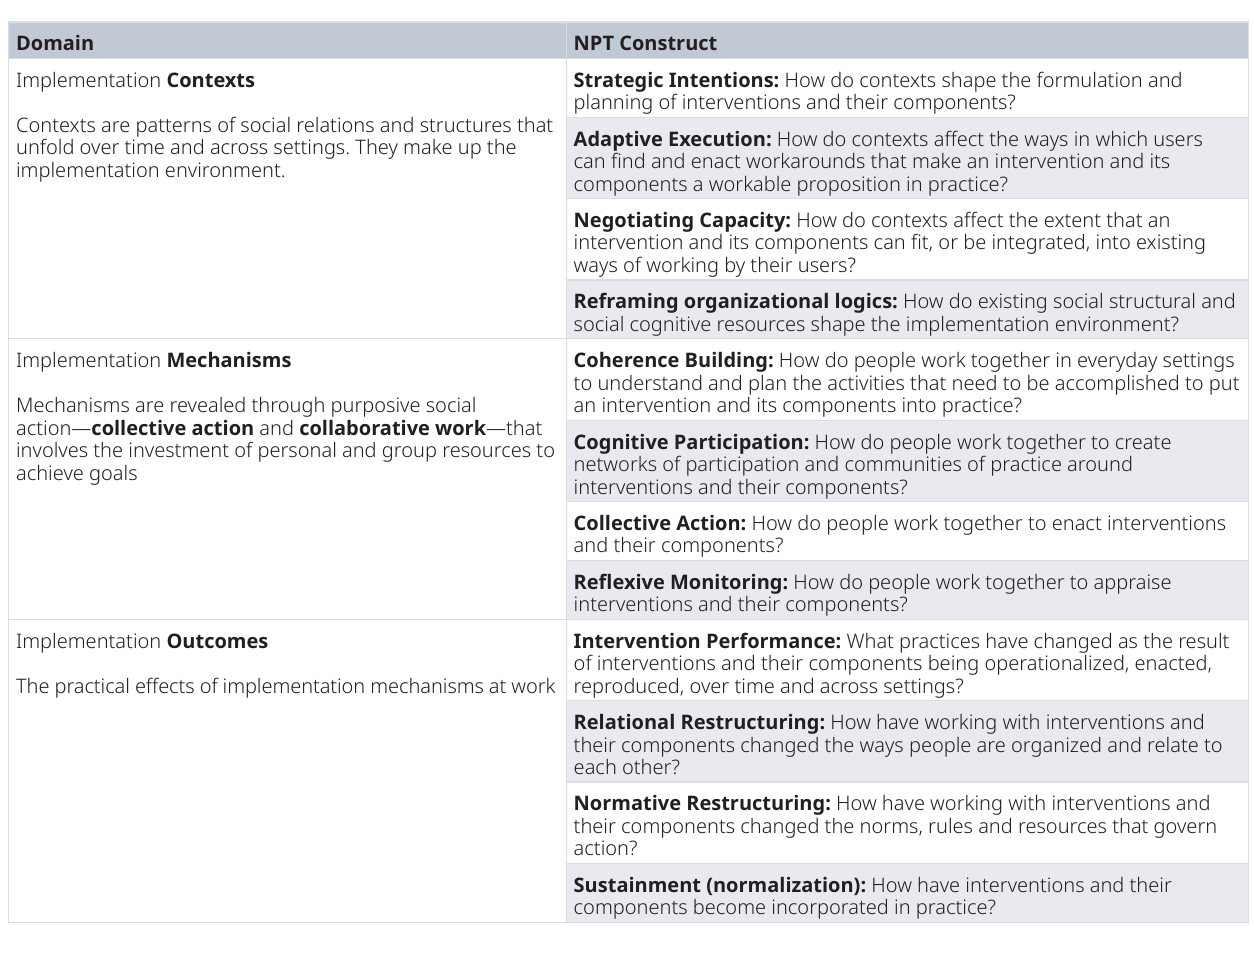
Table 2. Normalization Process Theory (NPT) coding manual part A: Contexts, mechanisms, and outcomes 12 .